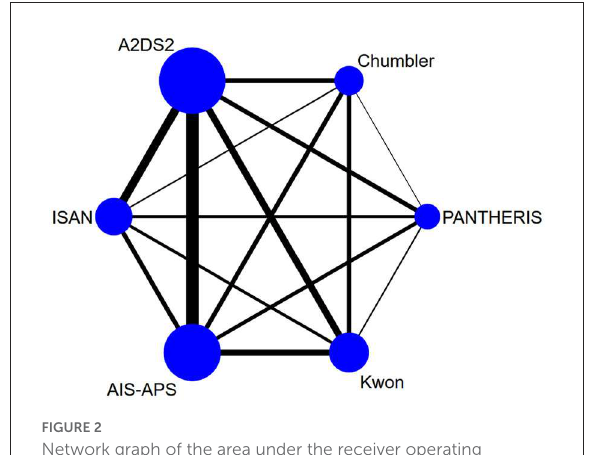
FIGURE2 Network graph of the area under the receiver operating characteristic (AUC).